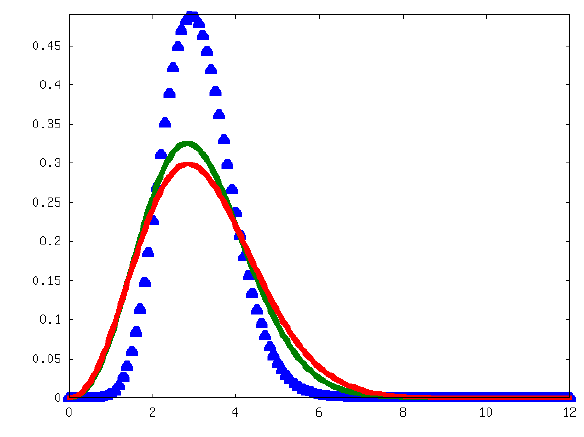
Fig. 1. Pdf for climate sensitivity (in degrees Celsius) from AH06 (blue triangles), pdf obtained by ignoring the volcanic cooling con- straint (green solid line) and pdf obtained by ignoring the volcanic cooling constraint and adding 0.5degrees to the upper and lower bound of the 95% confidence level in the pdf corresponding to the LGM (red solid